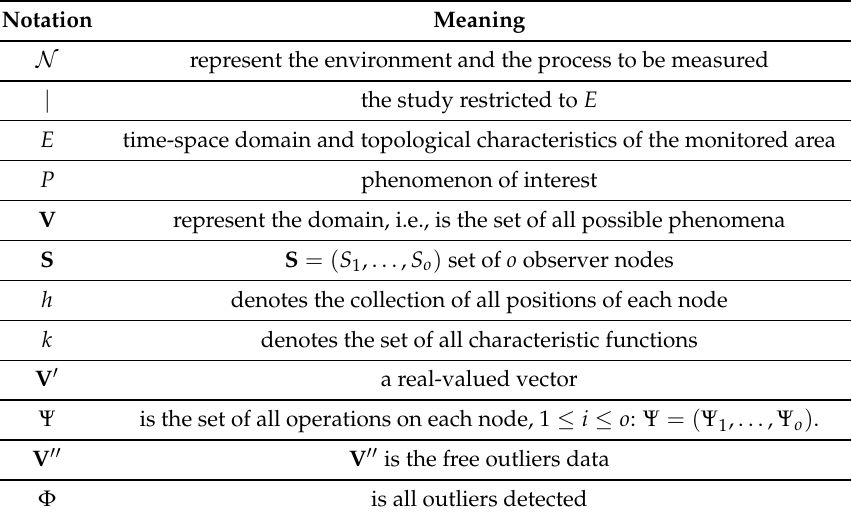
Table 1. Diagram